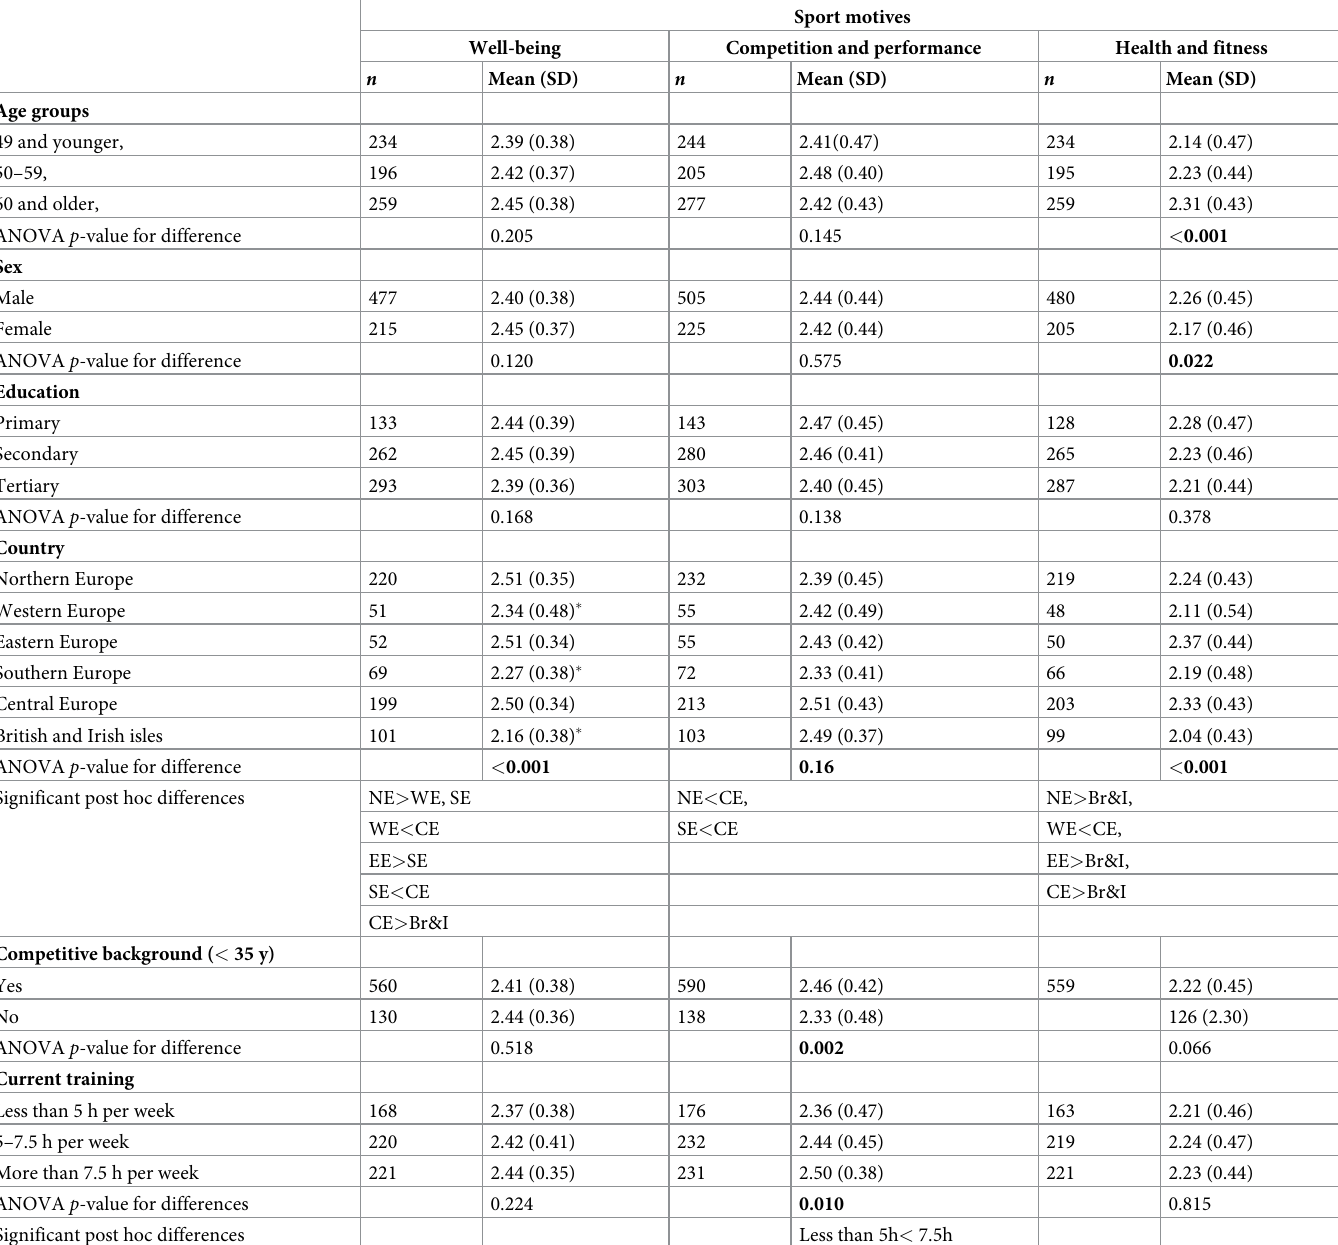
Table 2. Variation in sport motives across age, sex, education, country, competitive background and training